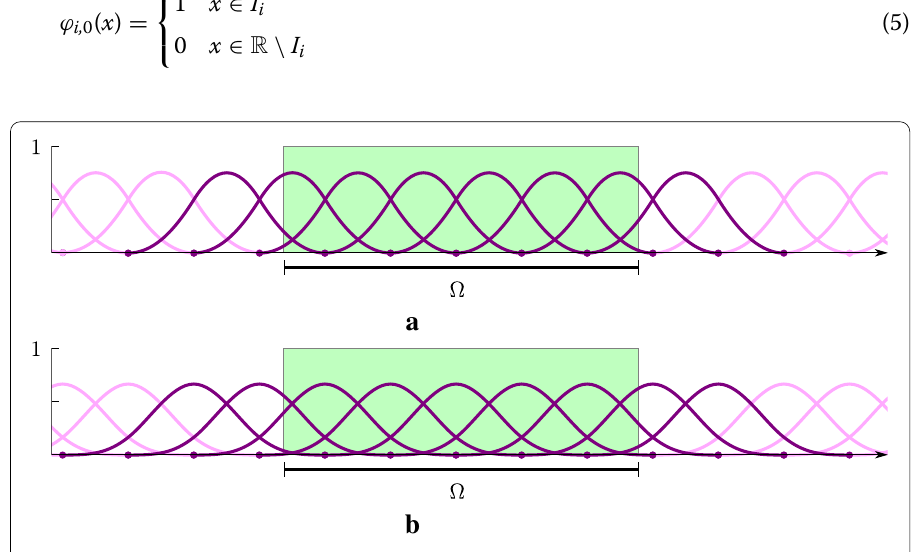
Fig. 1 B-spline basis functions in one dimension. The set B of basis functions with non-empty support in (cid:3) are indicated in deep purple. Note that basis functions crossing the boundary of (cid:3) are defined analogously to interior basis functions. a C 1 Q 2 ( R ). b C 2 Q 3 ( R